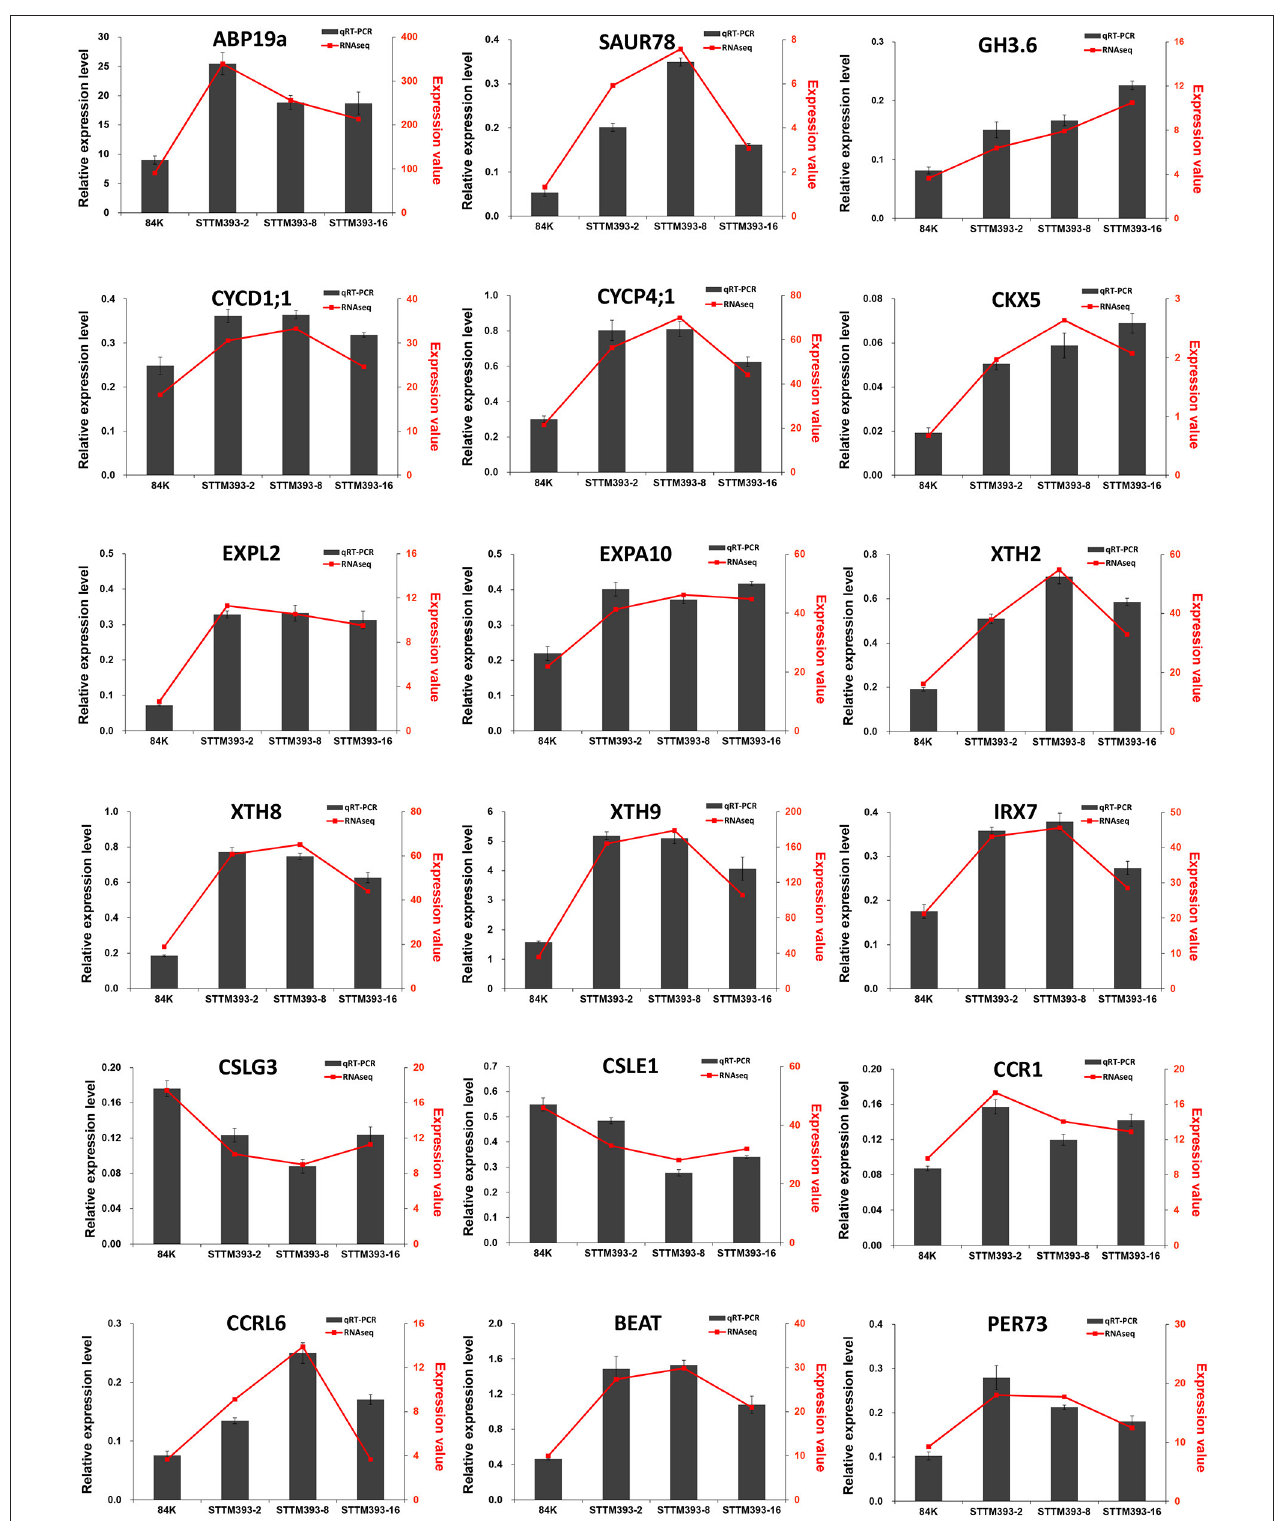
FIGURE 5 | Validation of key genes related to plant growth and wood formation by qRT-PCR using PP2A-2 as reference gene. The column represents the results of qRT-PCR, with the coordinate axis on the left (dark-grey). The line represents the results of transcriptome, with the coordinate axis on the right (red).